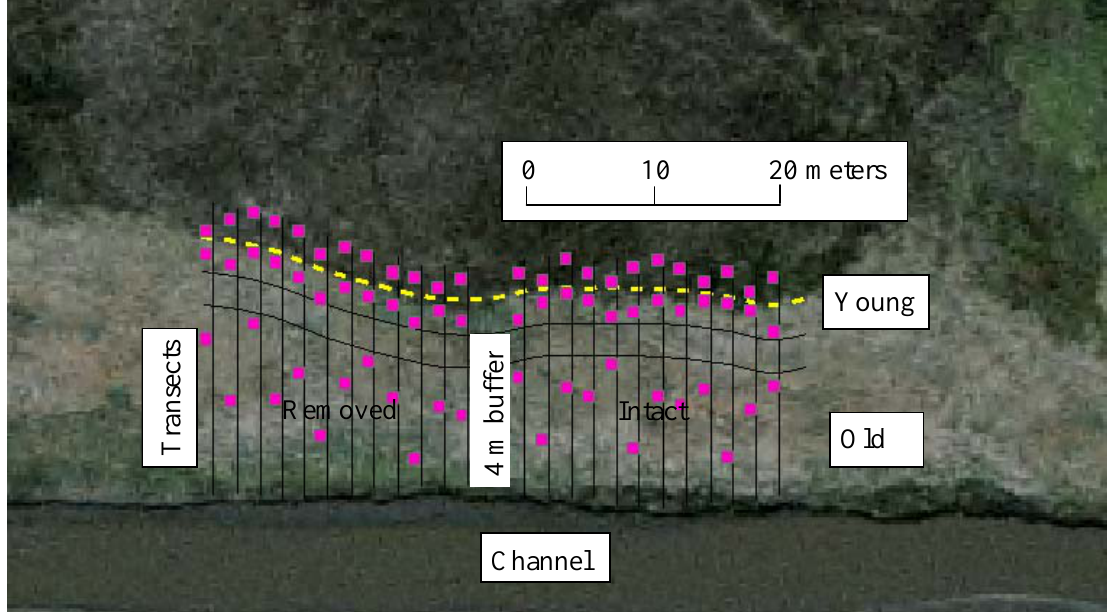
Figure 2. Diagram illustrating sample plot layout at one site. Purple squares signify 1 × 1 m quadrats. Transects pass through the perennial pepperweed invasion from the non-invaded edge (above the yellow dashed line) along a gradient from a sparsely-invaded (young) to a densely-invaded (old) area of the perennial pepperweed